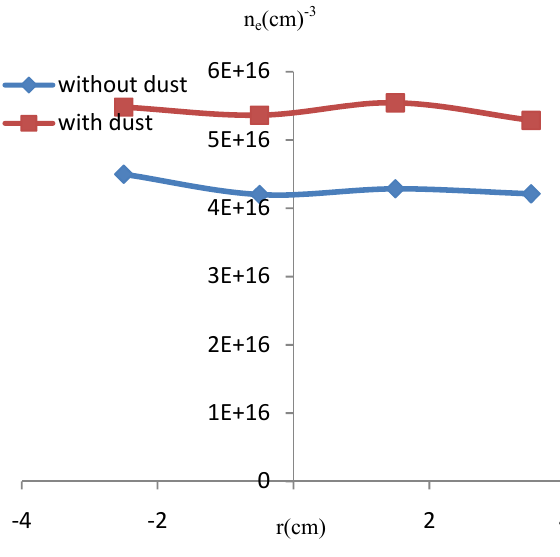
Fig. 15: Influence of Al dust on electron density.